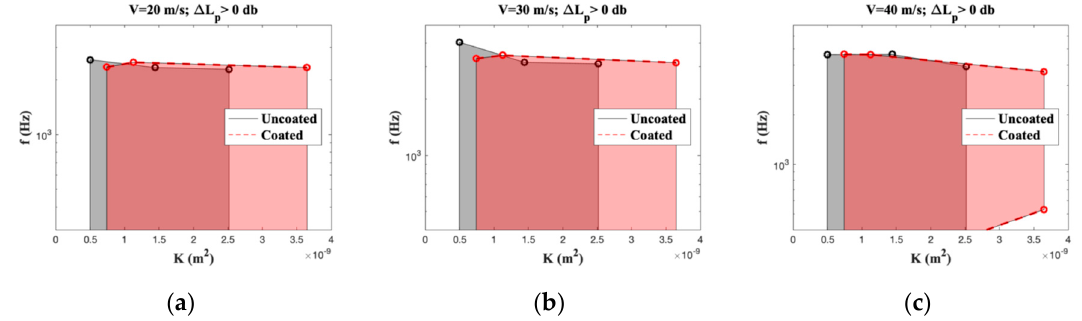
Figure 9. Comparison of frequency range 𝑓 for which noise reduction is positive at different permeabilities 𝐾 for different free-stream air velocities: ( a ) v = 20 m/s, ( b ) v = 30 m/s, and ( c ) v = 40 m/s.